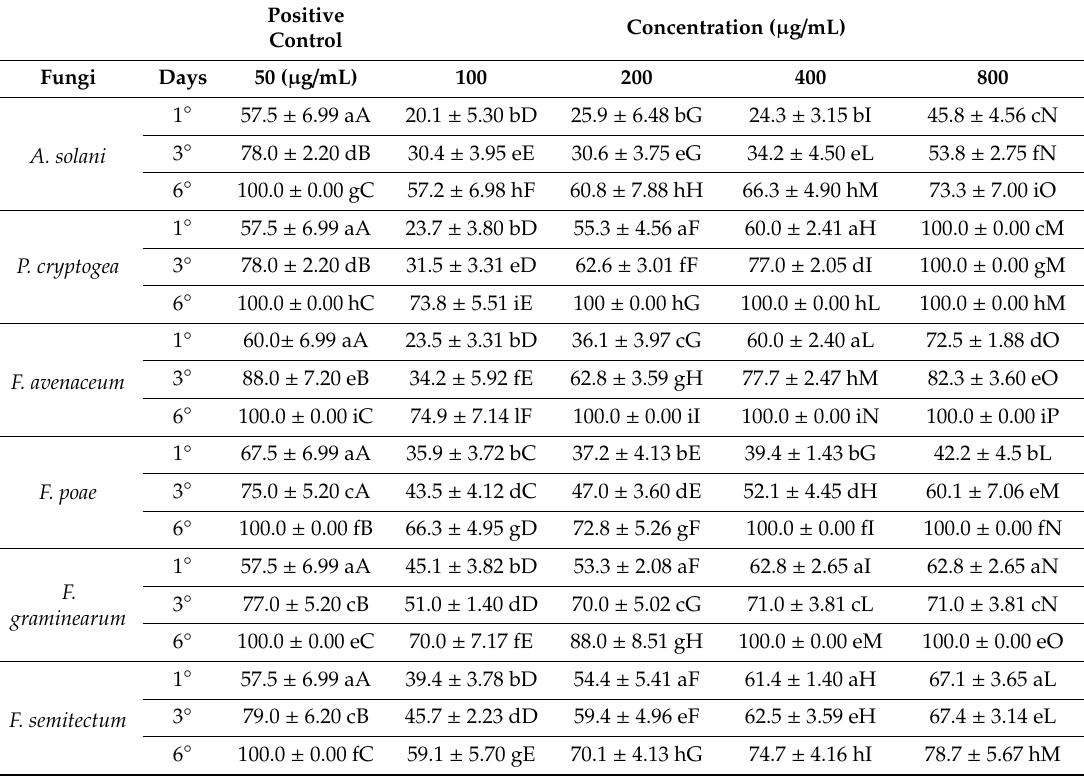
Table 1. E ff ect of Vepris macrophylla leaf essential oil (VEO) on the in vitro growth of selected fungal pathogens (%